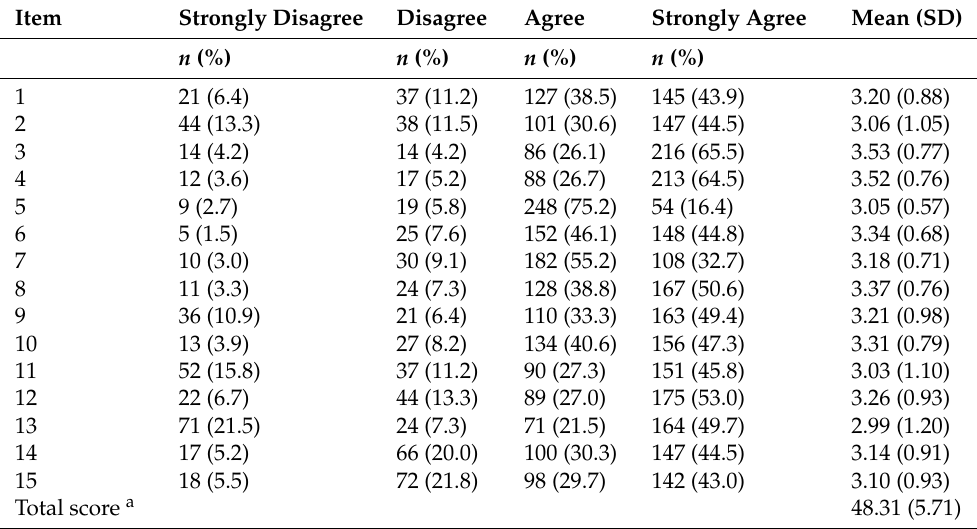
Table 2. Results of the descriptive analysis of perceived diabetes knowledge ( n =